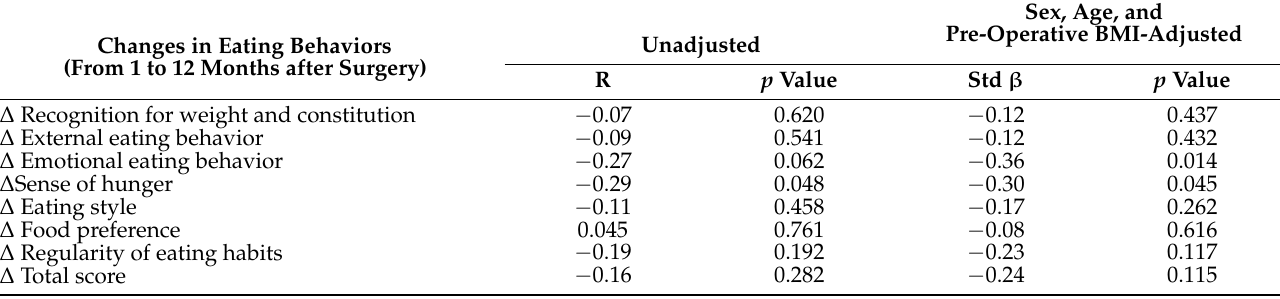
Table 5. Correlations between changes in eating behavior scores from 1 to 12 months after surgery and %EWL at 12 months after